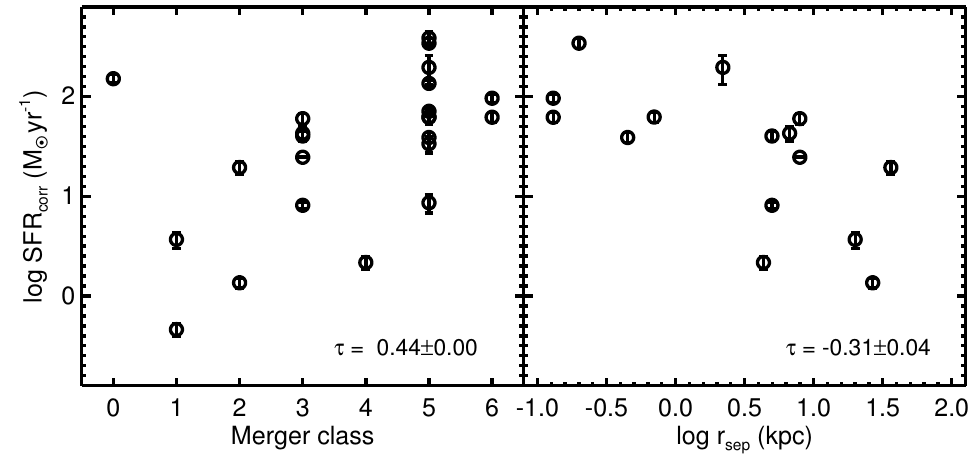
Figure 10. Dust-corrected nuclear SFR on logarithmic scales as a function of the merger class ( left ) and nuclear separation log r sep ( right ). The correlation coefficient τ is given in each panel; data points reproduced here are taken from U et al. [93] with authors’ permission. The merger classification scheme was adopted from Haan et al. [203] and Kim et al. [204] as follows: (0) a single galaxy with no obvious companion, (1) separate galaxies with symmetric disks and no tidal tails, (2) distinguishable progenitor galaxies with asymmetric disks and/or tidal tails, (3) two distinct nuclei sharing a common envelope, (4) closely-separated nuclei with visible tidal tails, (5) a single nucleus with prominent tails, and (6) a post-merger